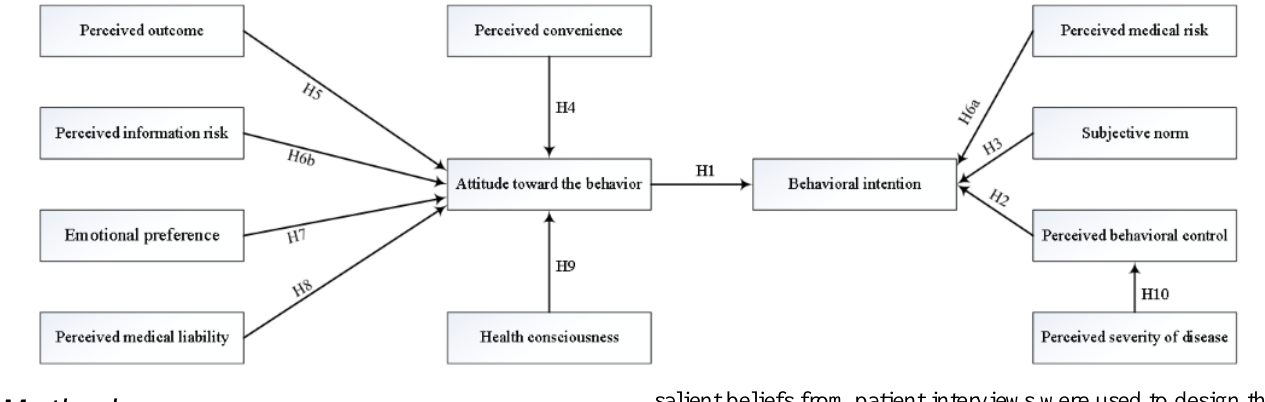
Figure 1. Structural research